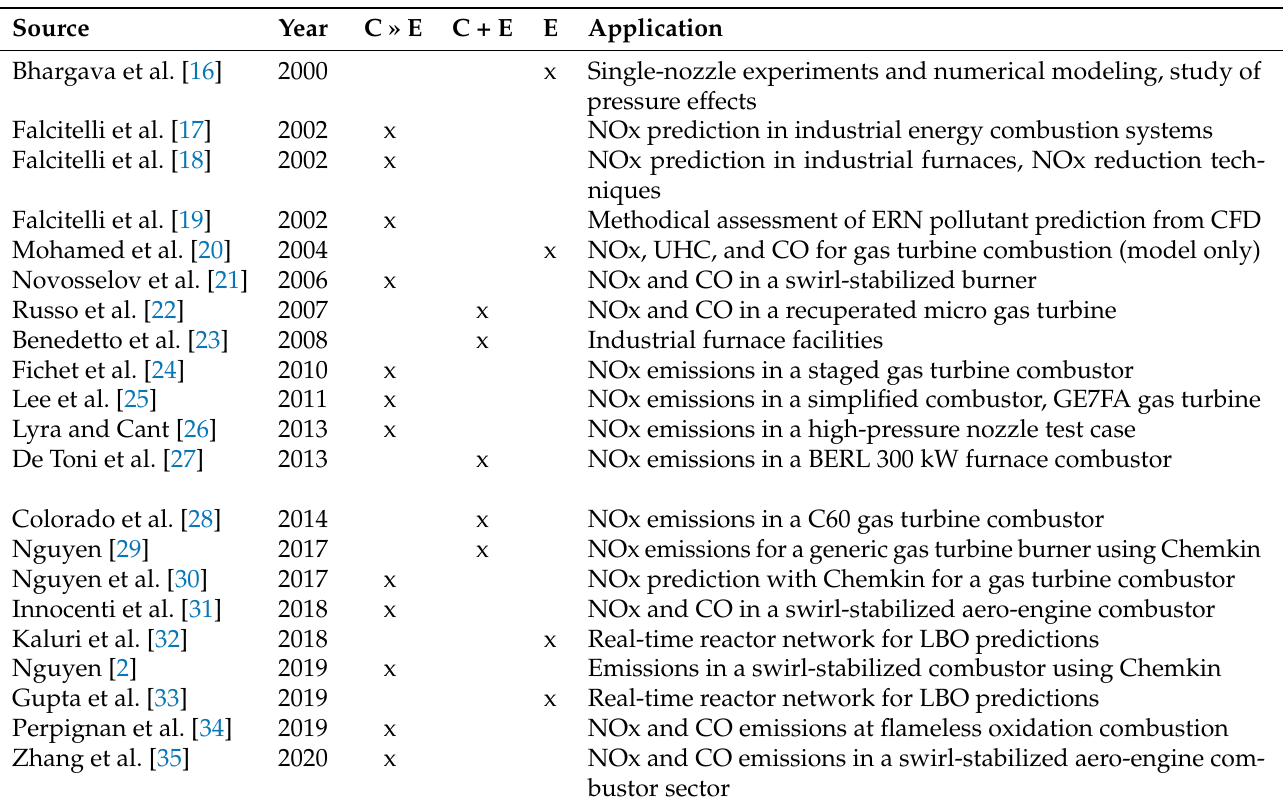
Table 1. Literature overview on ERN-based pollutant emission prediction, selected studies. C»E: extraction of networks from CFD. C+E: using CFD as guidance or estimation for ERN creation. E: reactor networks without